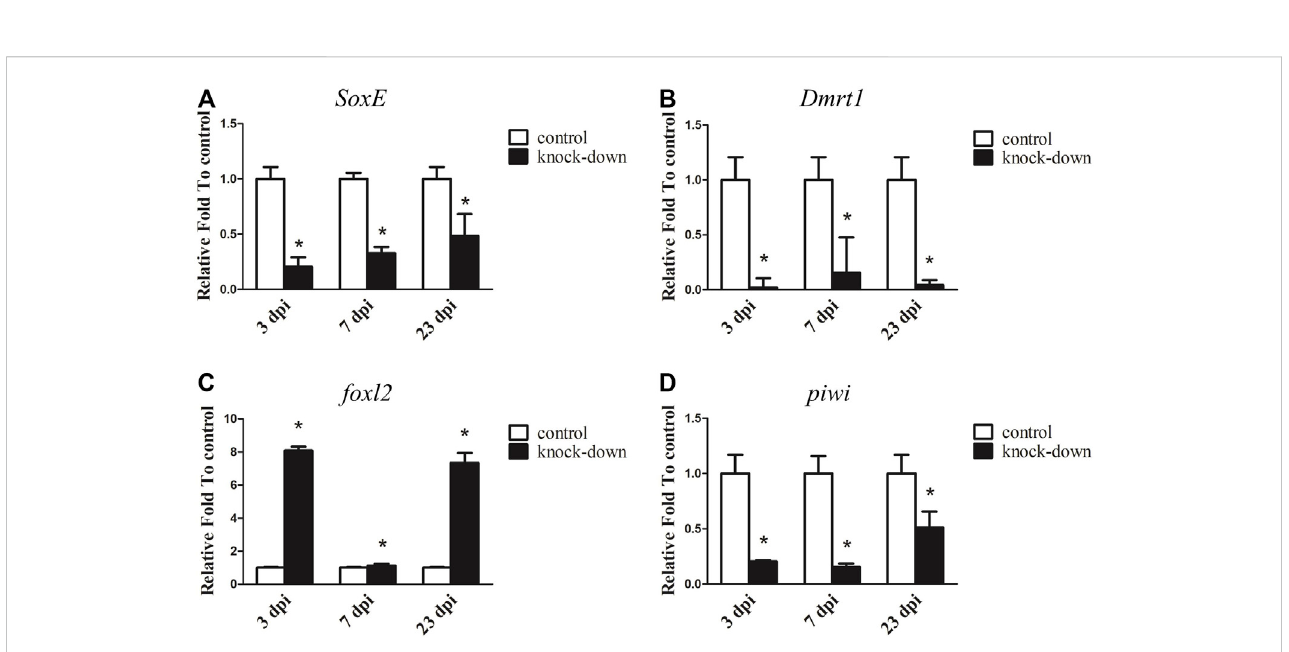
FIGURE 5 RNA interference (RNAi) of SoxE in testis. RT-qPCR detected mRNA levels of SoxE and other sex related genes after SoxE RNAi. (A) SoxE . (B) Dmrt1 . (C) foxl2. (D) piwi .NADHwasusedasinternalcontrol.Datawereperformedfromthreeindependentexperiments.Eachbarrepresentsmean±standarddeviation (SD). Asterisks (*) indicate signi fi cant differences ( p ≤ 0.05) between knock-down and control. dpi: days